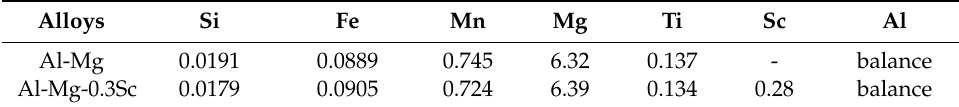
Table 1. Chemical compositions of the welding wires (mass%).